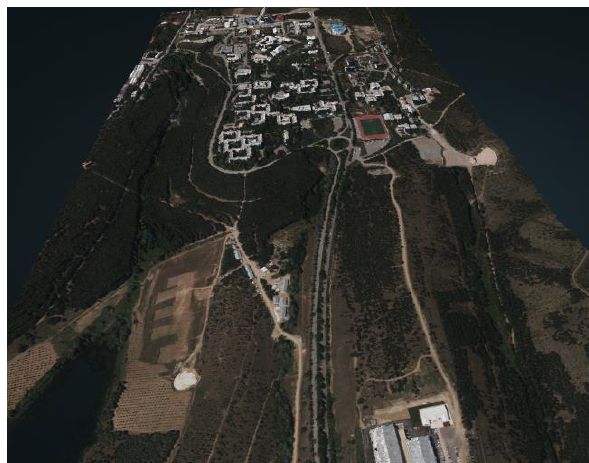
Figure 7. Visualisation of dense point cloud on Potree web interface.